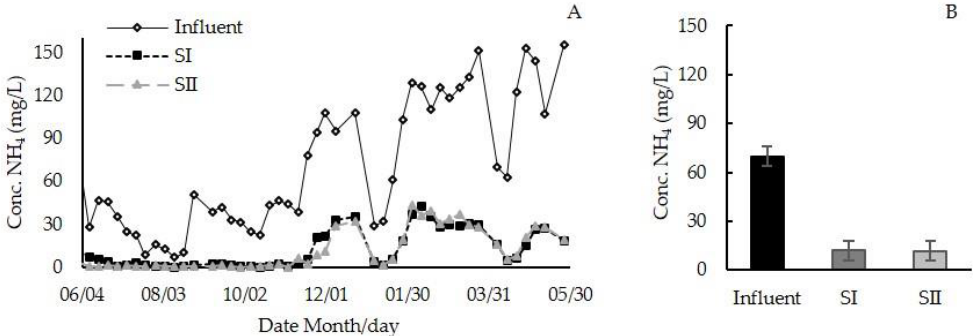
Figure 9. Ammonium concentrations in the study with PS VF wetlands, ( A ) values along the sampling campaigns, ( B ) mean concentrations ( ± standard error) throughout the period of study.